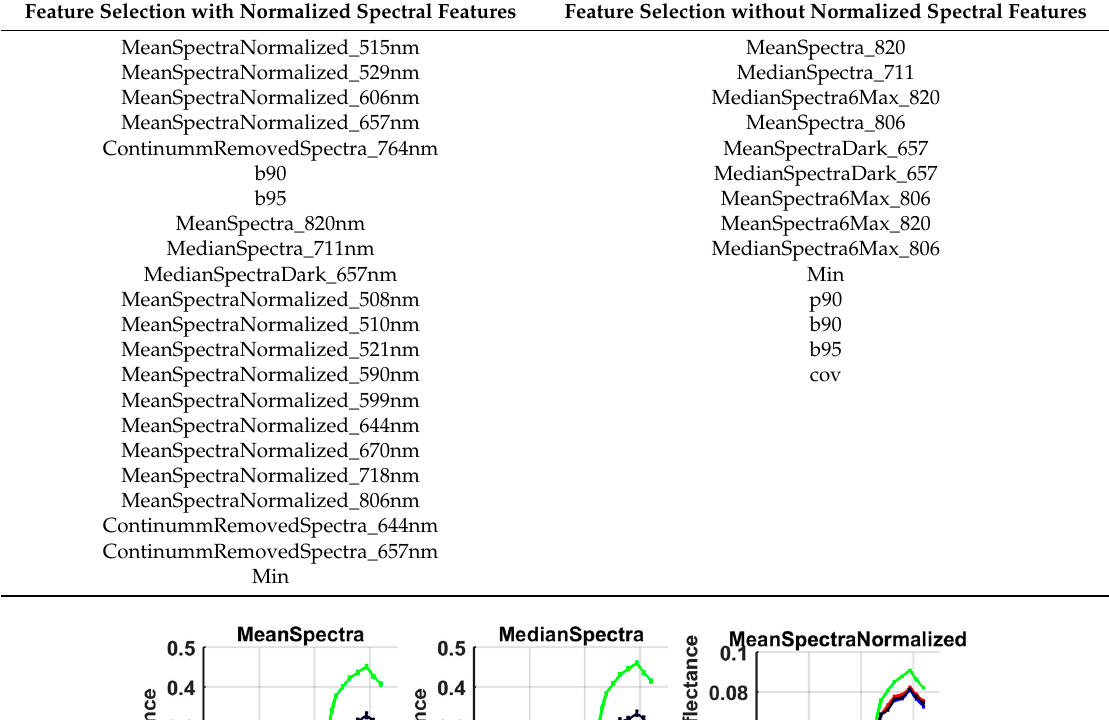
Table 10. The best performing features selected by the feature selection methods, with and without normalized spectral features.